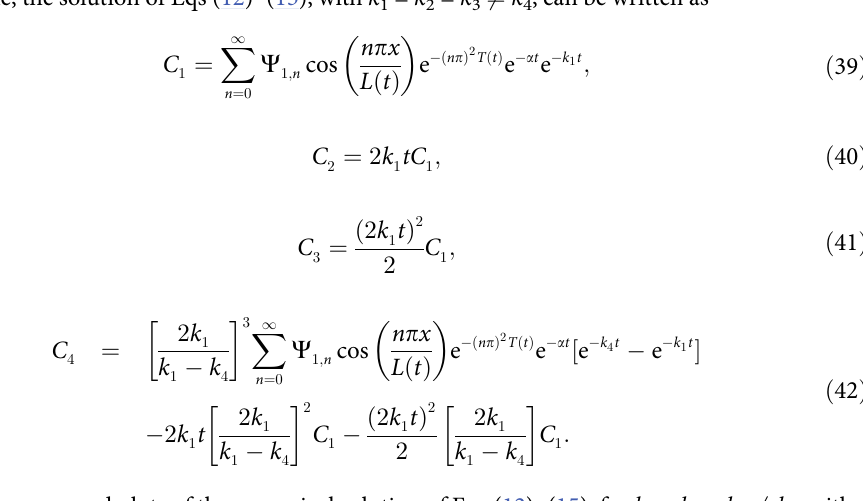
k k k 1 = 2 = 3 = 4 = 0.1.